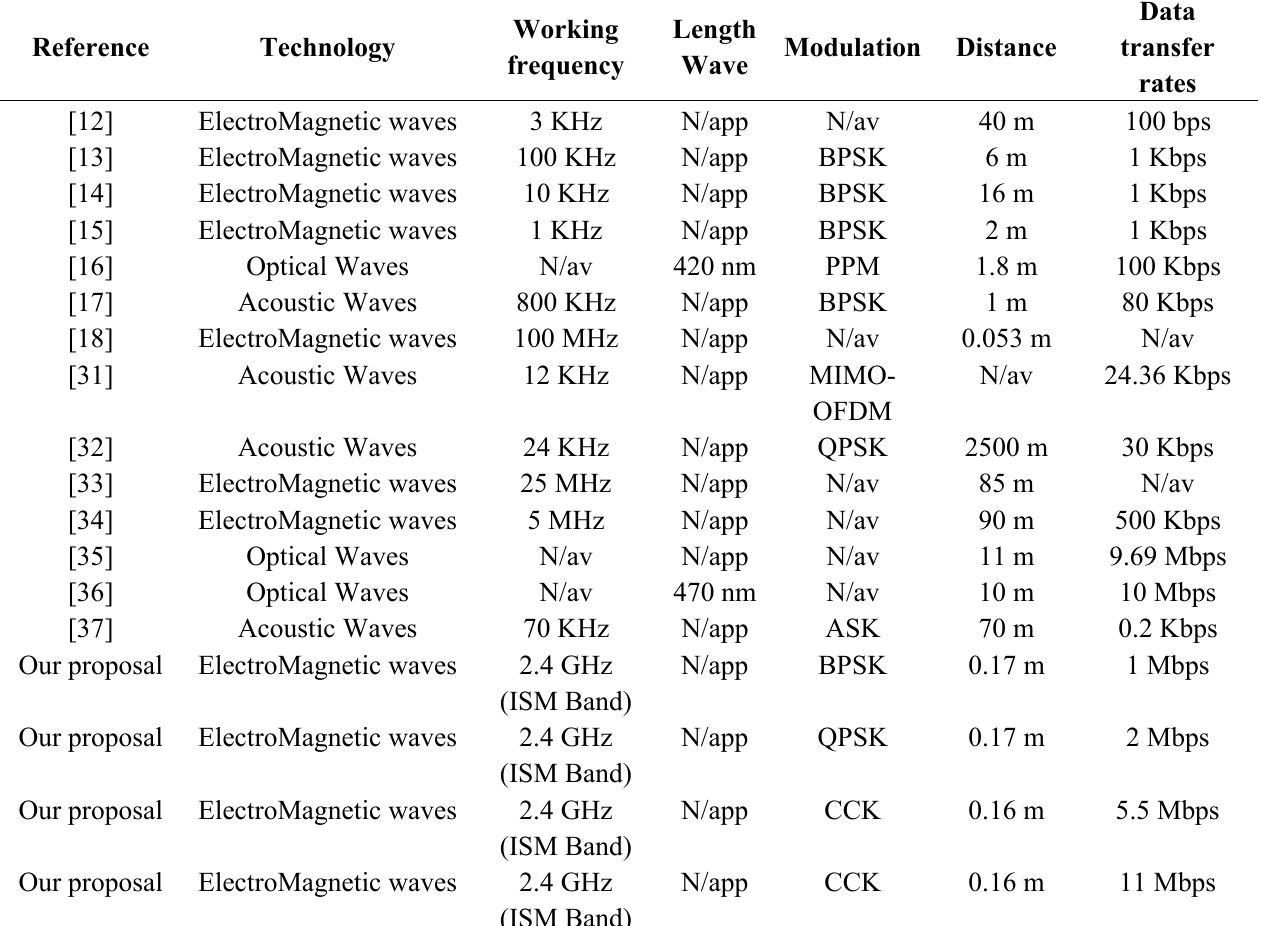
Table 6. Comparison